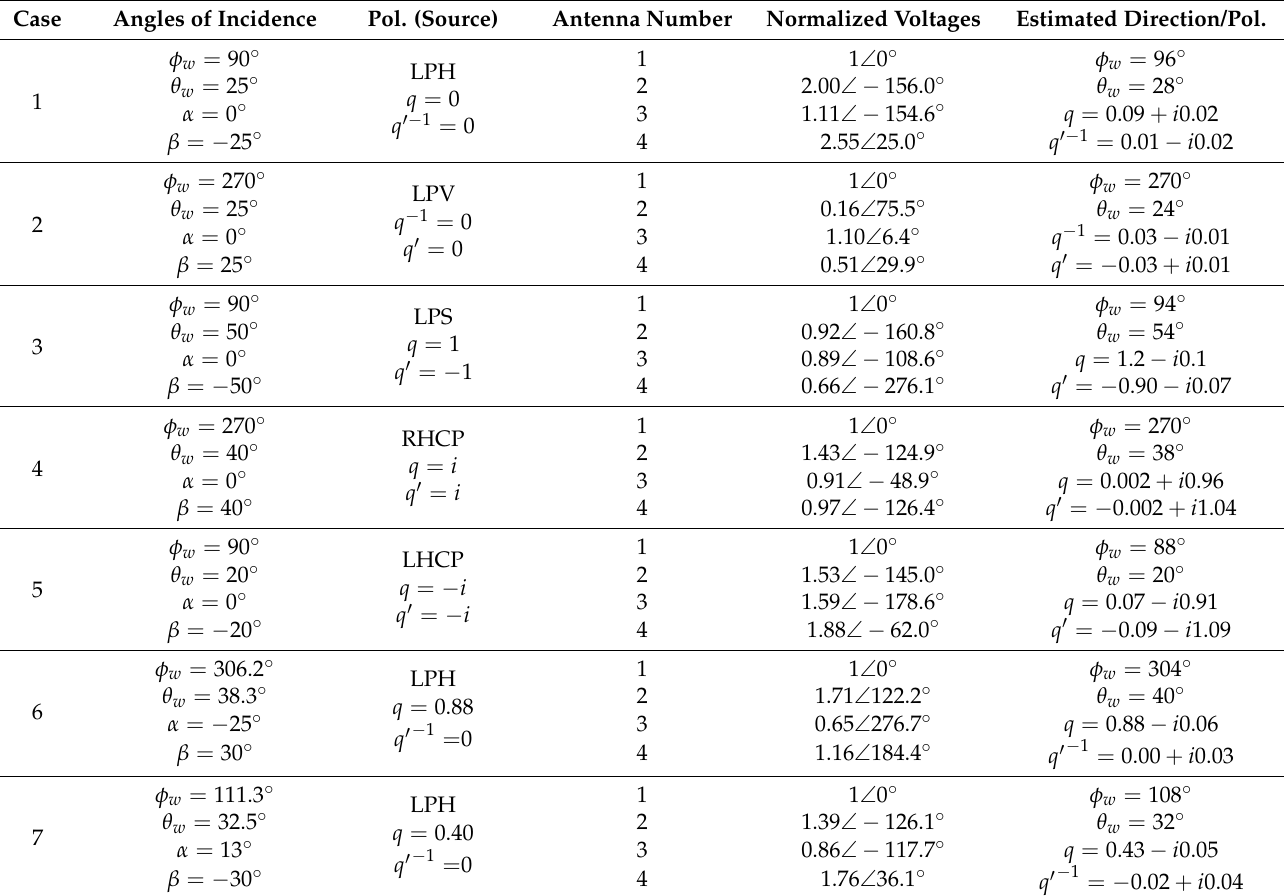
Table 5. Experimental results with the microstrip antenna